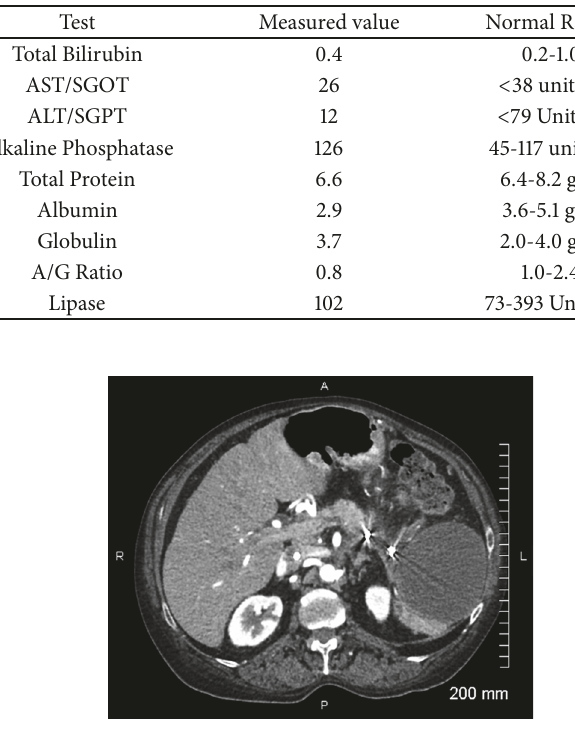
Figure 8: CT image: infarcted